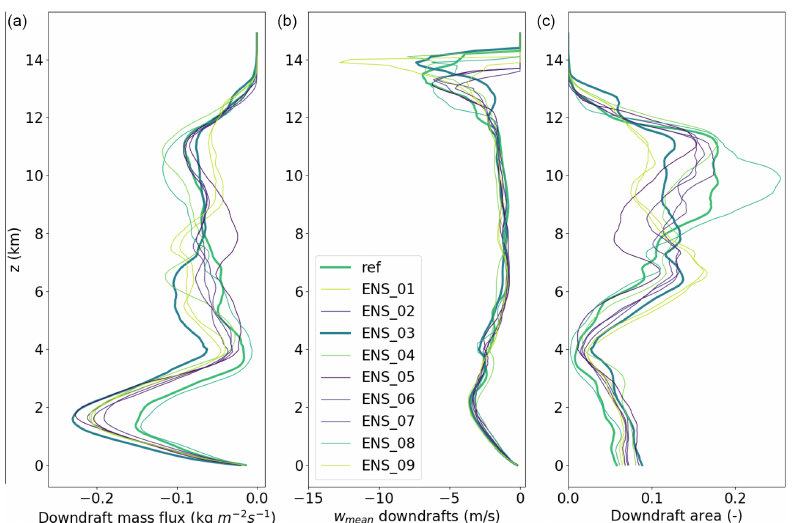
Figure 10. Instantaneous profile of squall line downdraughts at t = 75min. (a) Downdraught mass flux, (b) mean conditional w and (c) fractional area. The simulations are coloured in the order of their initial z i , with low interfaces in lime and high interfaces in purple (reference and ENS-03: bold). Table 1. Statistical relations between quantities of interest. R 2 > 0 . 4 is significant at α = 0 . 05; z i refers to the top height of the shear layer,